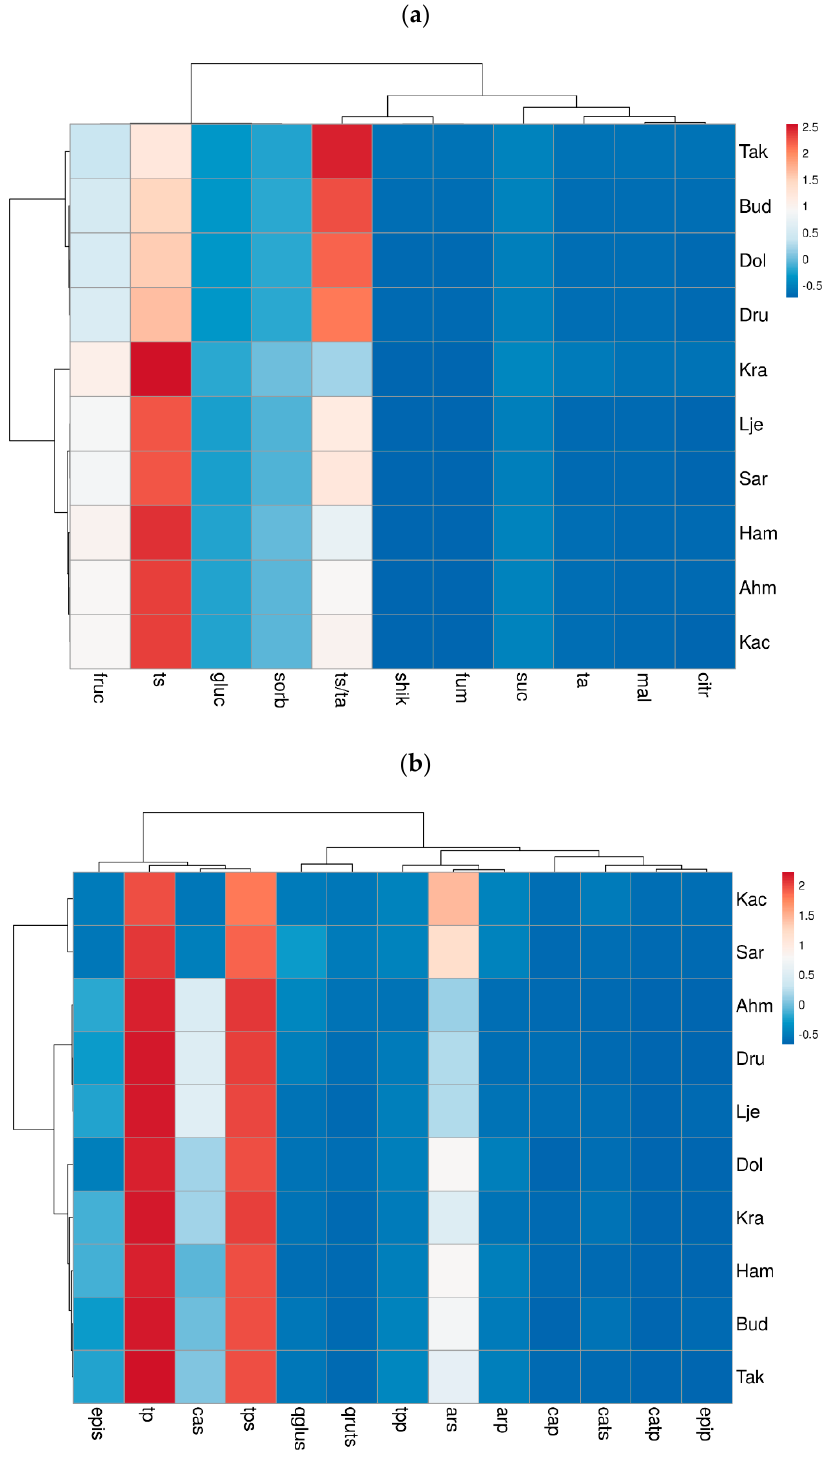
Figure 2. Heatmap of ( a ) sugars and organic acids and ( b ) polyphenol compounds detected in 10 different pear cultivars based on the relative abundance of different compounds.